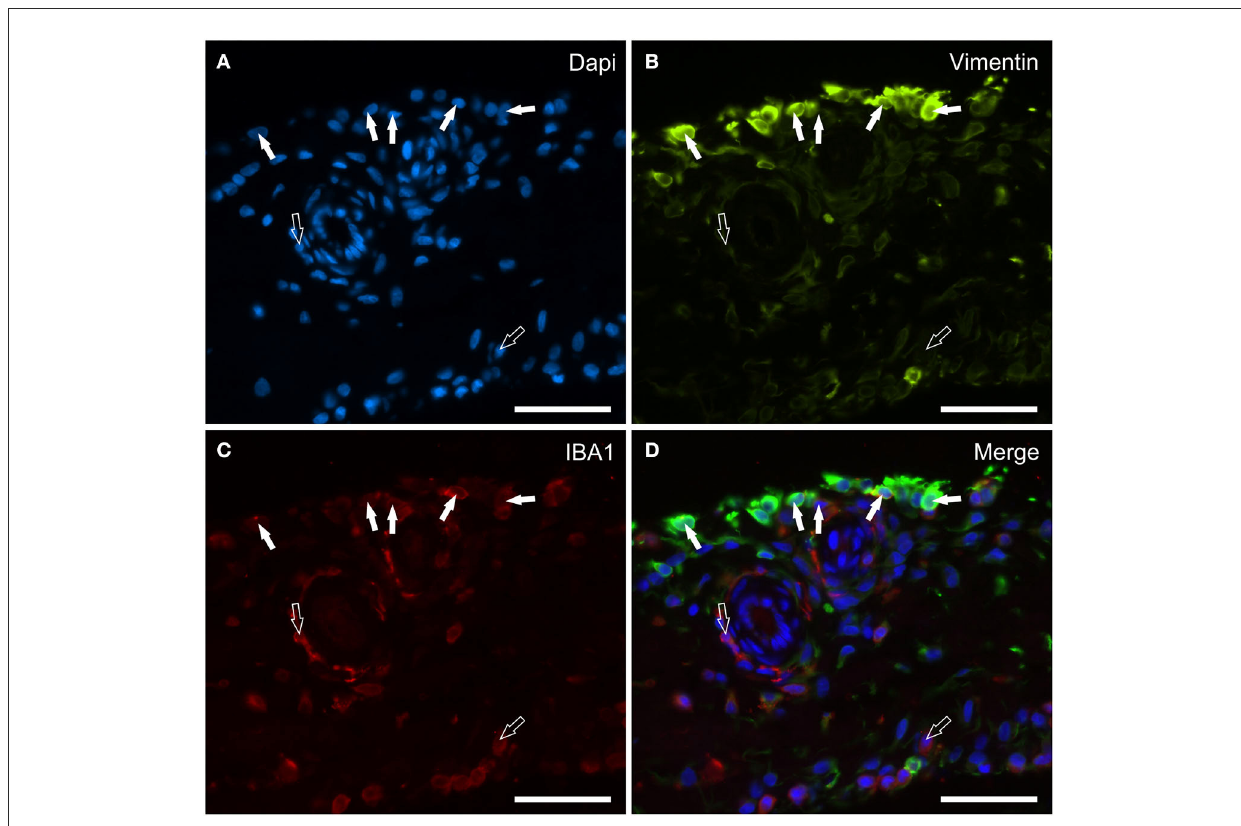
FIGURE2 Photomicrographs of the cryosections of the synovial membrane of a horse metacarpophalangeal joint showing vimentin (B) and IBA1 (C) immunoreactivity. The white arrows indicate the DAPI (Blue) labeled nuclei (A) of some macrophage-like synoviocytes lining the synovial intima which co-expressed moderate IBA1 (Red) and bright vimentin (Green) immunoreactivity. The open arrows indicate subintimal macrophages, which were IBA1 immunoreactive and vimentin negative. (D) Merged image (Orange). Scale bar = 50 µ